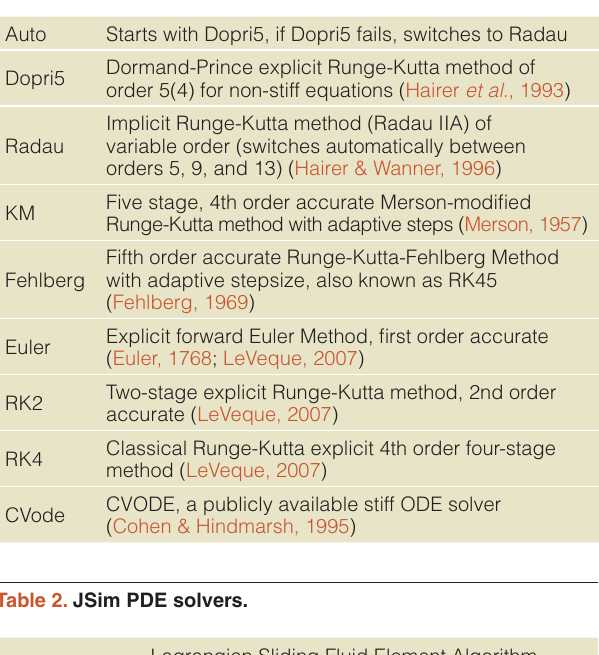
Table 1. JSim ODE solvers.